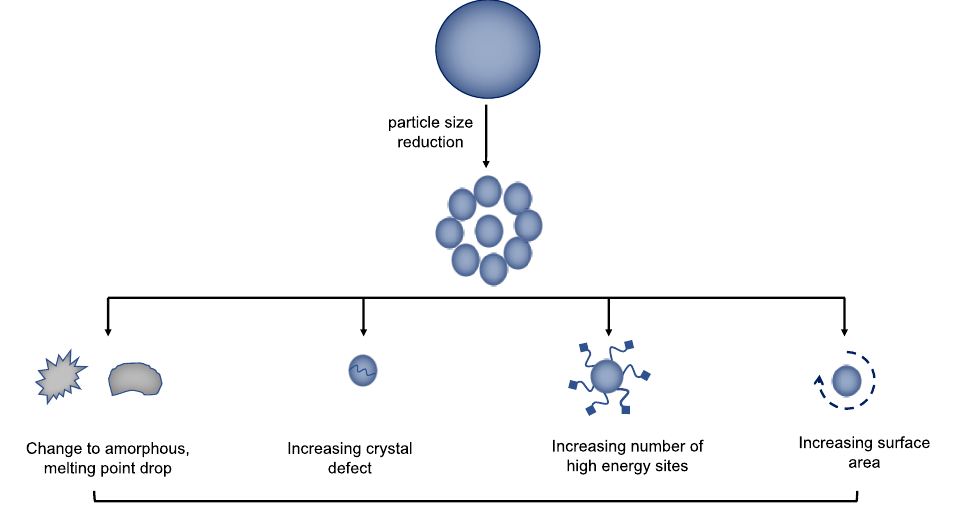
Figure 4. The relationship between particle size reduction of drug and its solubility enhancement. Adapted from data presented originally in Ref [49].